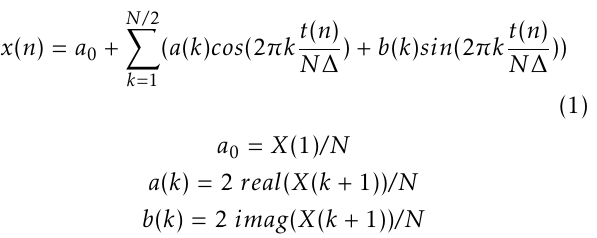
stimuli were labelled as r10, r100, b10, b100, w10 and